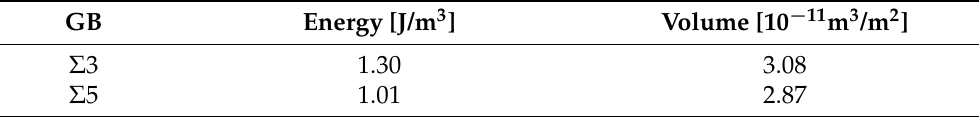
Figure 1. Magnified view of ( a ) Σ 3 and ( b ) Σ 5 GB regions. The horizontal and the vertical direction are the x- and the y-direction, respectively. The direction perpendicular to the paper surface is the z-direction. The light gray particles represent Fe atoms in the GB region and the blue particles are the other Fe atoms. The numbers (0–3) in the figure shows P segregation sites used in the simulation. Table 1. GB energy and GB volume [25].